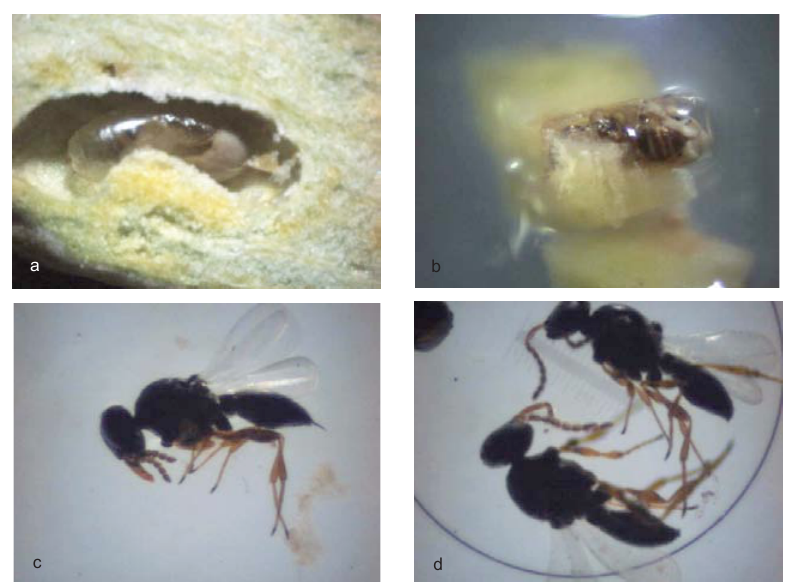
Figure 3. Parasitoid wasp. © Moawia Mohamed (a) inside the midge larva, (b) inside the midge larva freed from the gall, (c) adult (female) and (d) adults